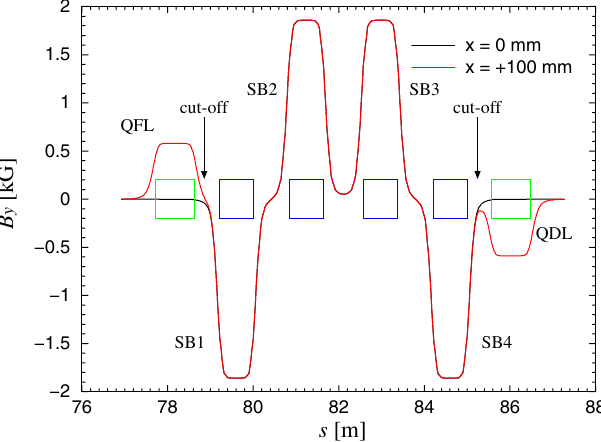
distribution in the shift-bump field area at y x (cid:4) 0 and (cid:5) 100 mm with y (cid:4) 0 . The cutoffs are introduced in order to distinguish the dipole field from the quadrupole field.